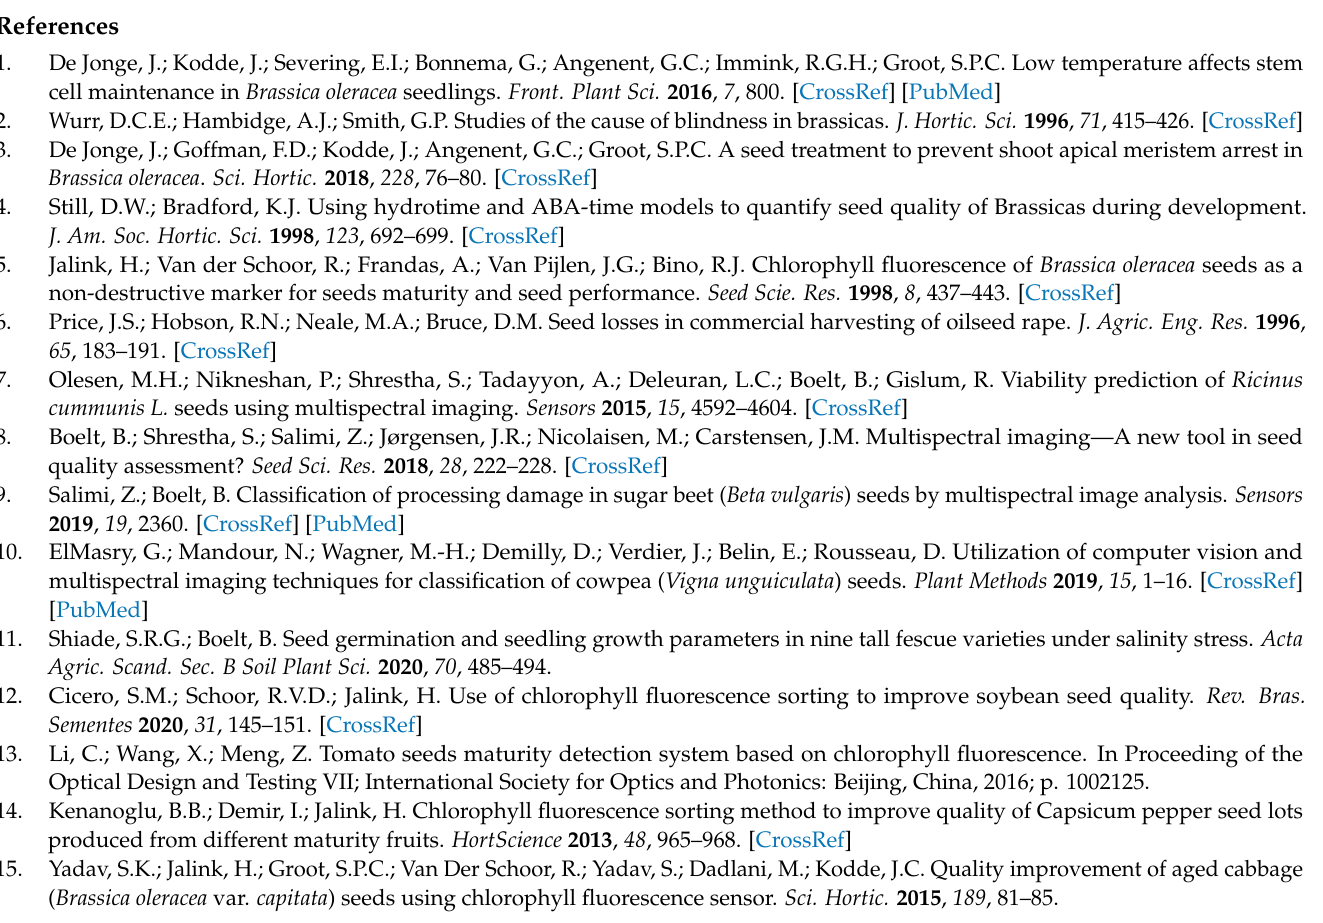
Figure S1: Brassica control seed respiration curves at 20 ◦ C, Figure S2: Brassica control seed respiration curves at 15 ◦ C, Figure S3: Pearson correlation matrix of selected parameters, Figure S4: Full correlation